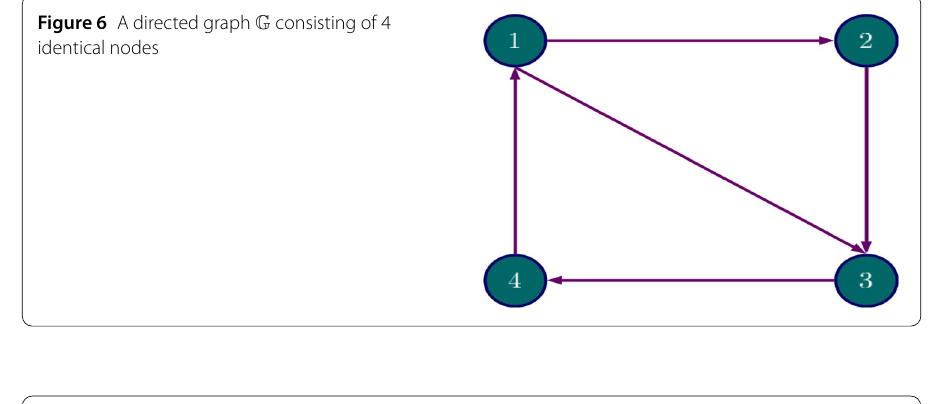
Figure 6 A directed graph G consisting of 4 identical